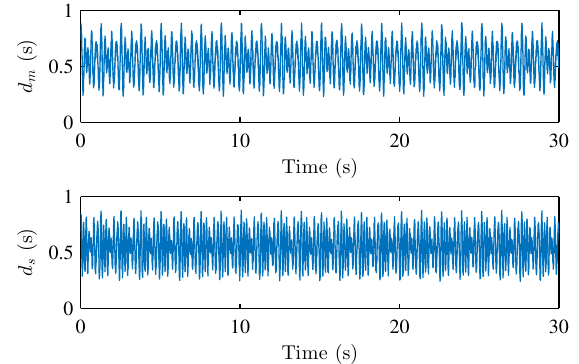
Figure 2. Forward and backward time-varying delays d m and d s .